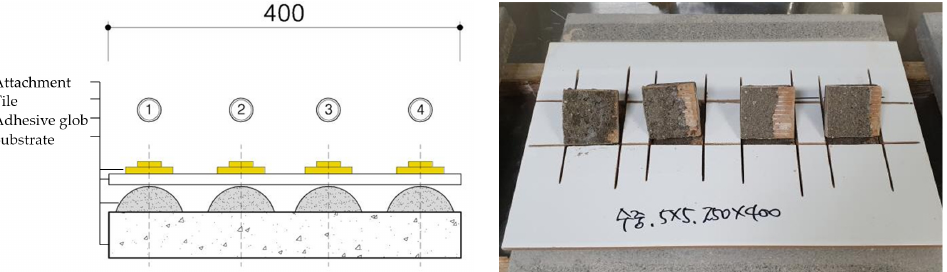
Figure 6. Specimen and test method illustrated for the ISO (International Standard Organization) standard pull-off test.